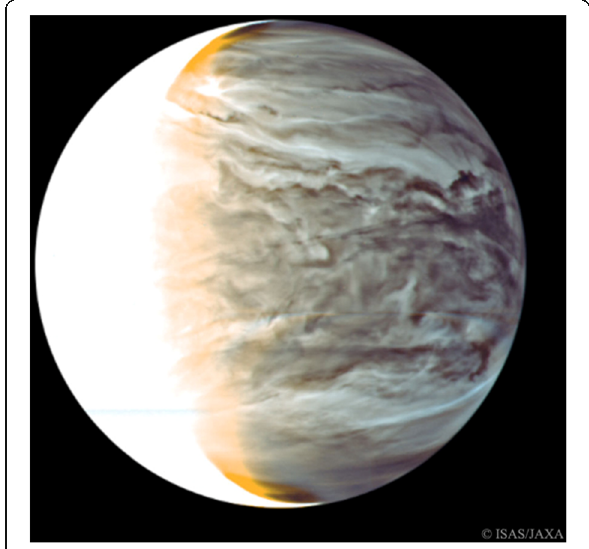
Fig. 12 The deeper view into Venus ’ clouds afforded by near-infrared windows (this example from the Akatsuki 2-micron camera) shows structures on a range of length scales — if lightning is associated with cloud convection as on Earth, it might be expected that lightning will be similarly patchy (see also Fig.